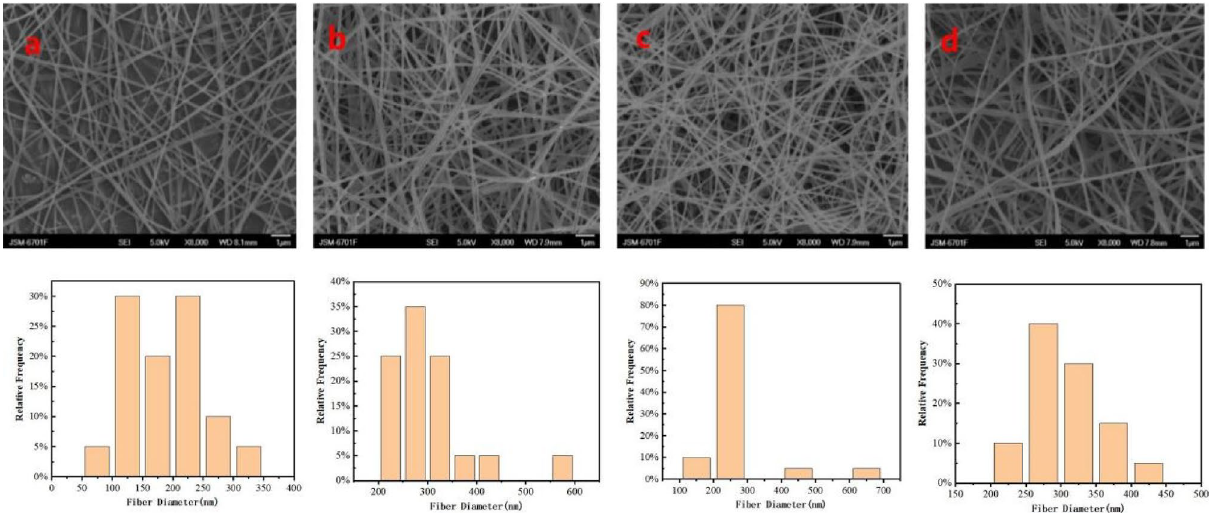
Figure 4. SEM images of electrospinning CMKN fibers at different pushing speed and fiber diameter distribution (( a ):0.2 ml/h; ( b ):0.5 ml/h; ( c ):0.8 ml/h; ( d ):1 ml/h).